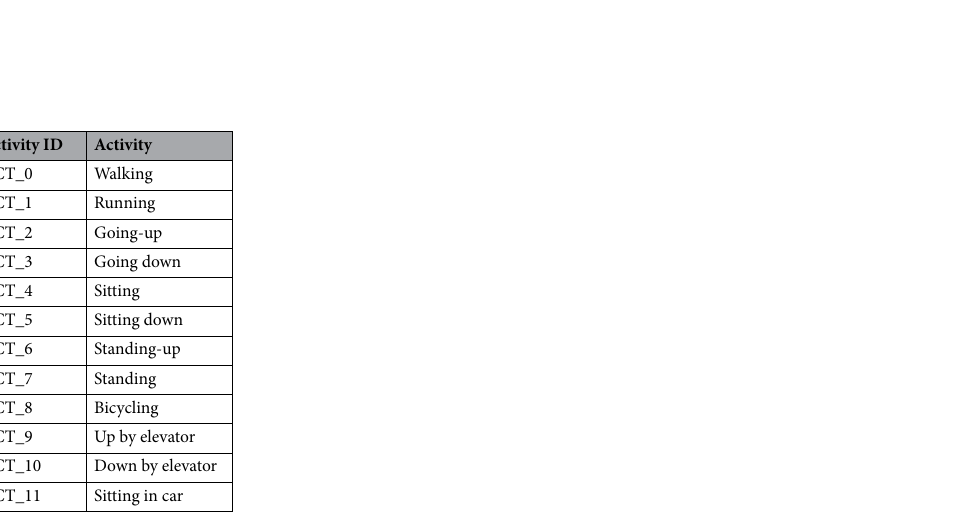
Table 4. A tabular representation of the classes of human activities performed in the HuGaDB